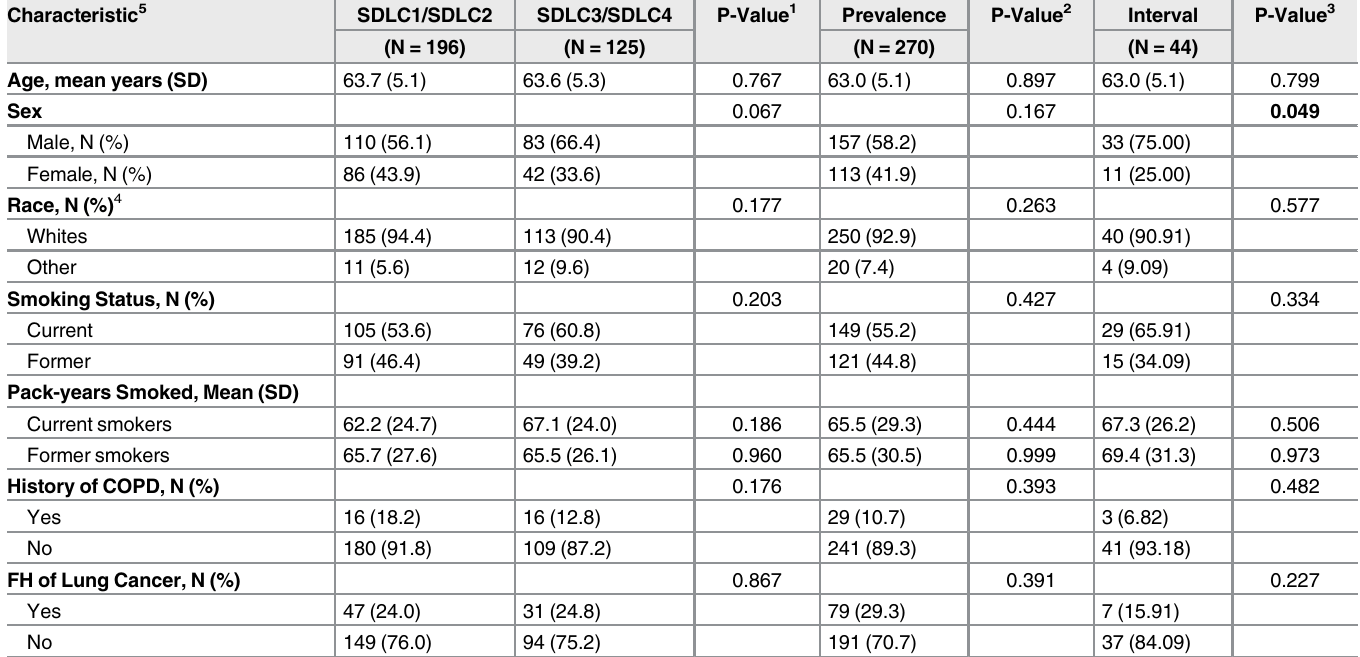
Table 2. Baseline Demographic of the Grouped Screen-Detected, Prevalence, and Interval Cancer